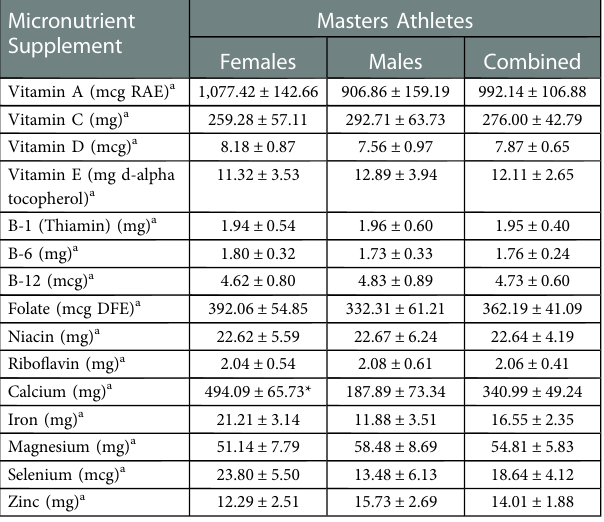
TABLE 4 Micronutrient supplementation among female and male masters